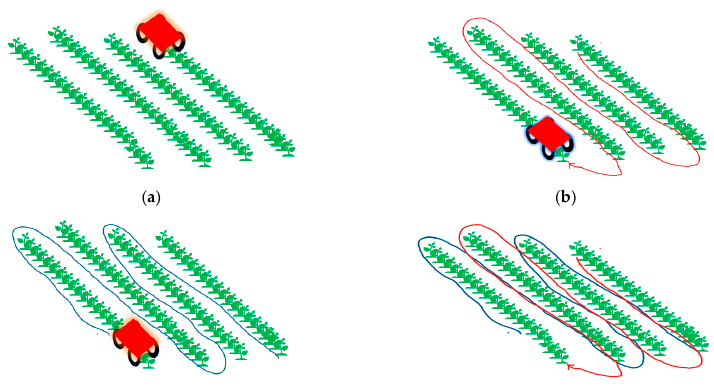
Figure 3. Tracking the robot using wheel odometry of the camera Inertial Measurement Units (IMU) (the autonomous rover can be tracked while working on the farm by using visual SLAM and GPS); ( a ) Rover is starting to navigate, ( b ) Rover is about to finish the farm ( c ) Rover can generate the returning path by using history navigation ( d ) Blue is the predicted path going back while red is the path taken by the rover.